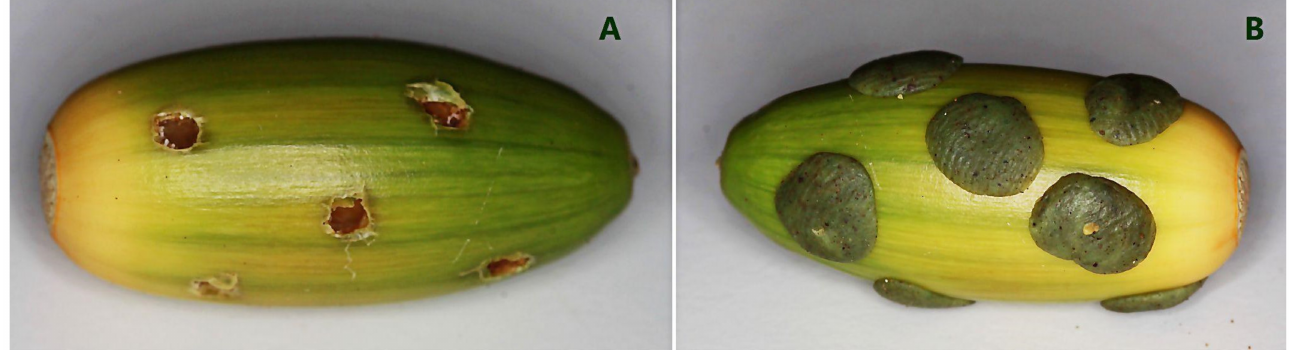
Figure 2. Experimental habitat for larvae: ( A )—artificially pierced fruit prepared for infestation; ( B )—infested acorn with holes closed with